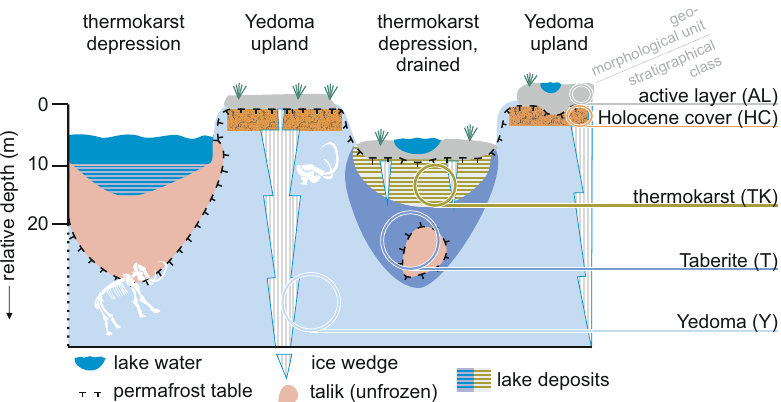
Fig.2|Conceptualmodelofthestratigraphicpositionanddegradationlegacy. Conceptual model of the stratigraphic position and degradation legacy (former freeze-thawing history) of the considered deposits: active layer (grey colour code, n =467), Holocene cover (orange, n =175), thermokarst deposits, (olive-green, n =479), Taberite (in-situ thawed, diagenetically altered but not relocated former Yedoma deposits, bluish-purple n =175), and Yedoma (ice-blue, n =917) deposits.